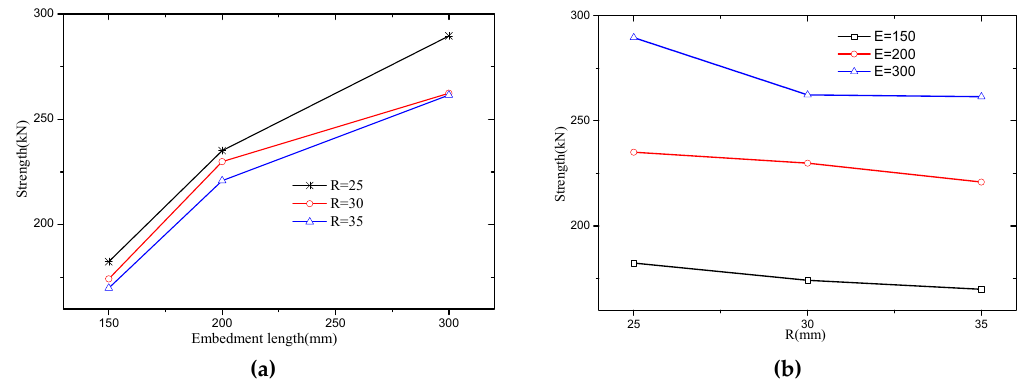
Figure 15. Parameter’s effect on strength of SCGPC. ( a ): Embedment length; ( b ): Radius.